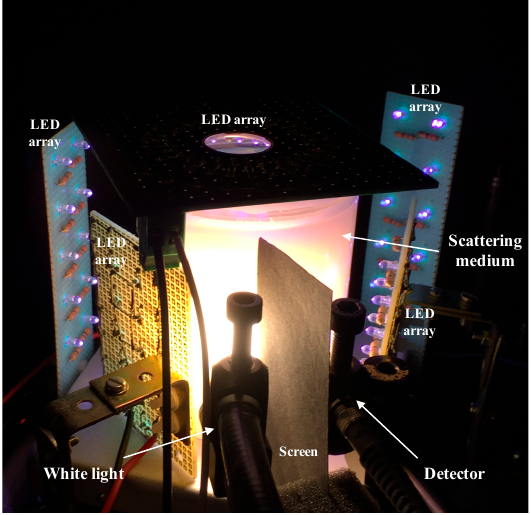
Figure 1. Implemented photocatalytic reactor with decolorization monitoring.